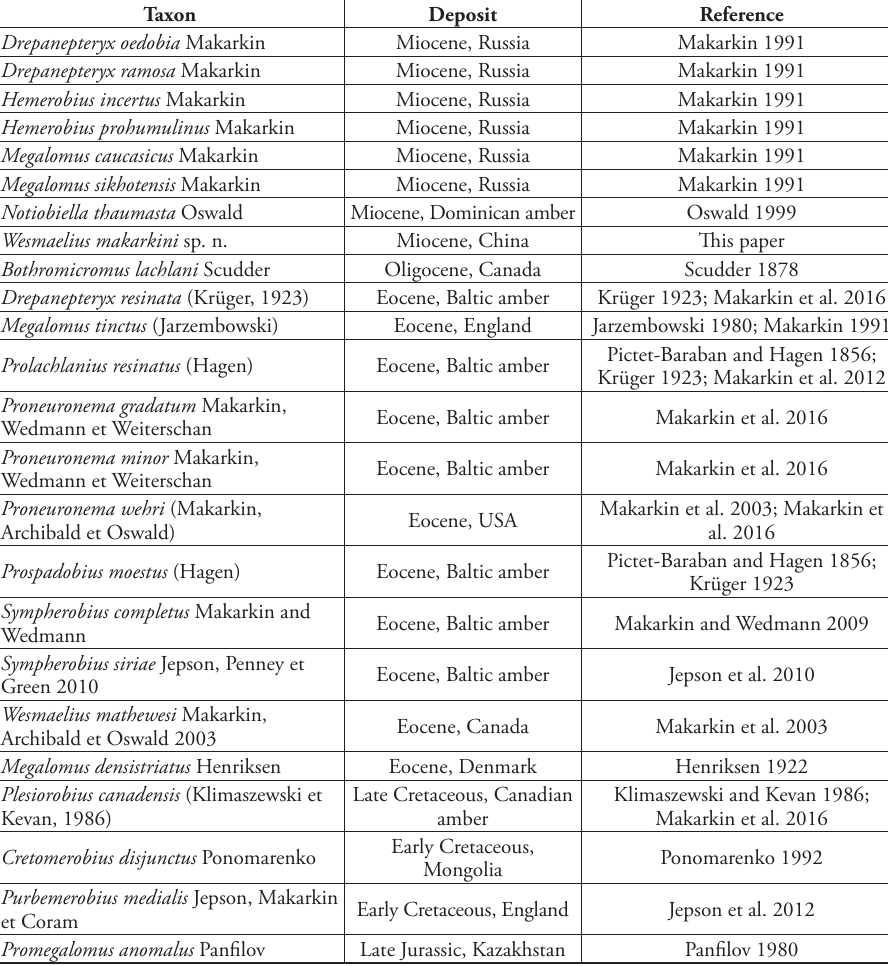
Table 1. List of Named Fossil Hemerobiidae (updated from Engel and Grimaldi